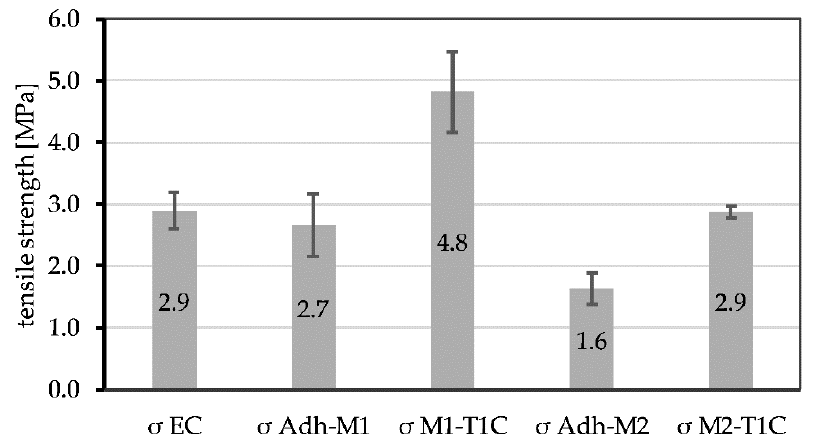
Figure 15. Tensile strengths of the existing concrete ( σ EC ) and the repair mortars ( σ M1 ‐ T1C and σ M2 ‐ T1C ), as well as the adhesive tensile strength between the concrete and repair mortar ( σ Adh ‐ M1 and σ Adh ‐ M2 ); mean values of five single values, with standard deviation indicated.